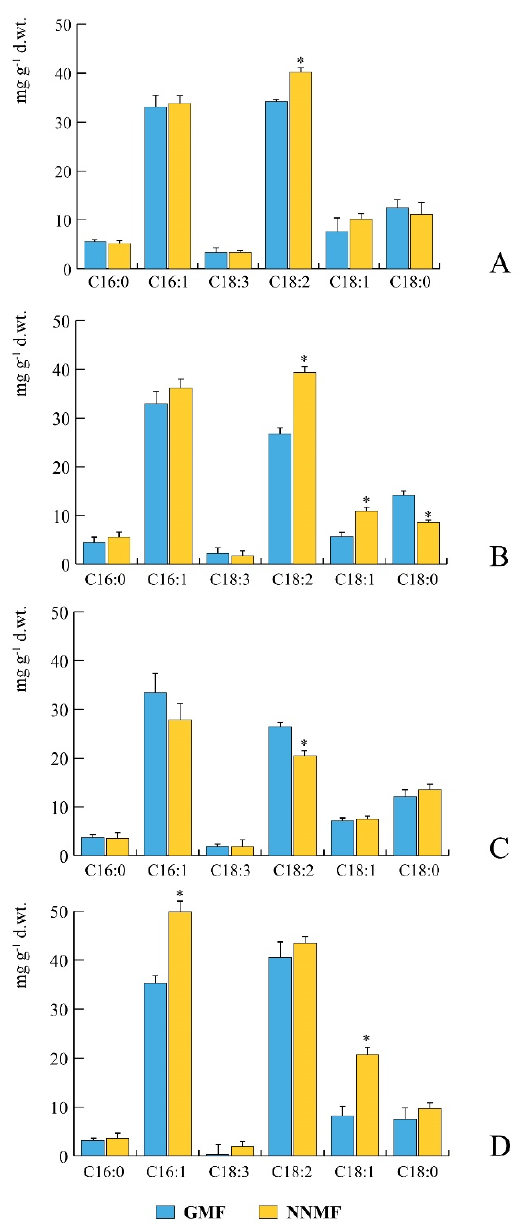
Figure 2. Developmental changes in fatty acid composition of Arabidopsis thaliana exposed to geomagnetic field (GMF, blue bars) or to near-null magnetic field (NNMF, yellow bars). ( A ), rosette developmental stage, 15 days old plants. ( B ), bolting developmental stage, 21 days old plants. ( C ), flowering developmental stage, 30 days old plants. ( D ), seed-set developmental stage, 35 days old plants. Bars represent standard deviation. *, significant ( p < 0.05) differences between NNMF and GMF plants.